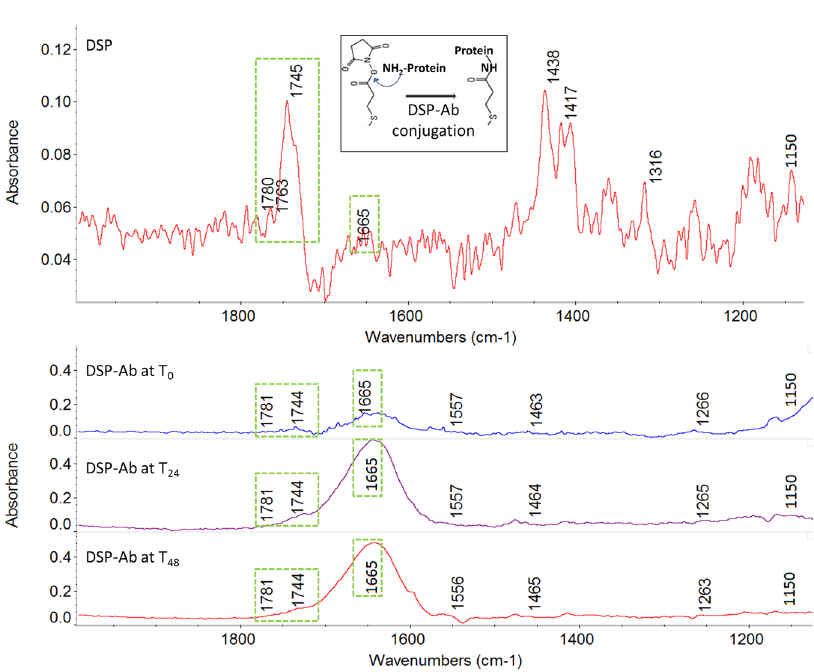
Figure 5. FTIR spectra of DSP linker immobilized on ZnO surface (top), α -IL-6 antibody immobilized on DSP linker after T 0 , T 24 and T 48 hours